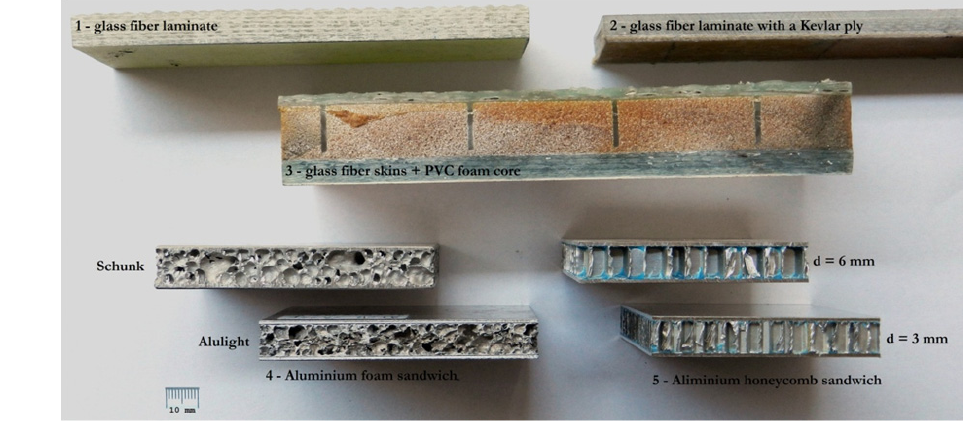
Figure 1: Investigated composite